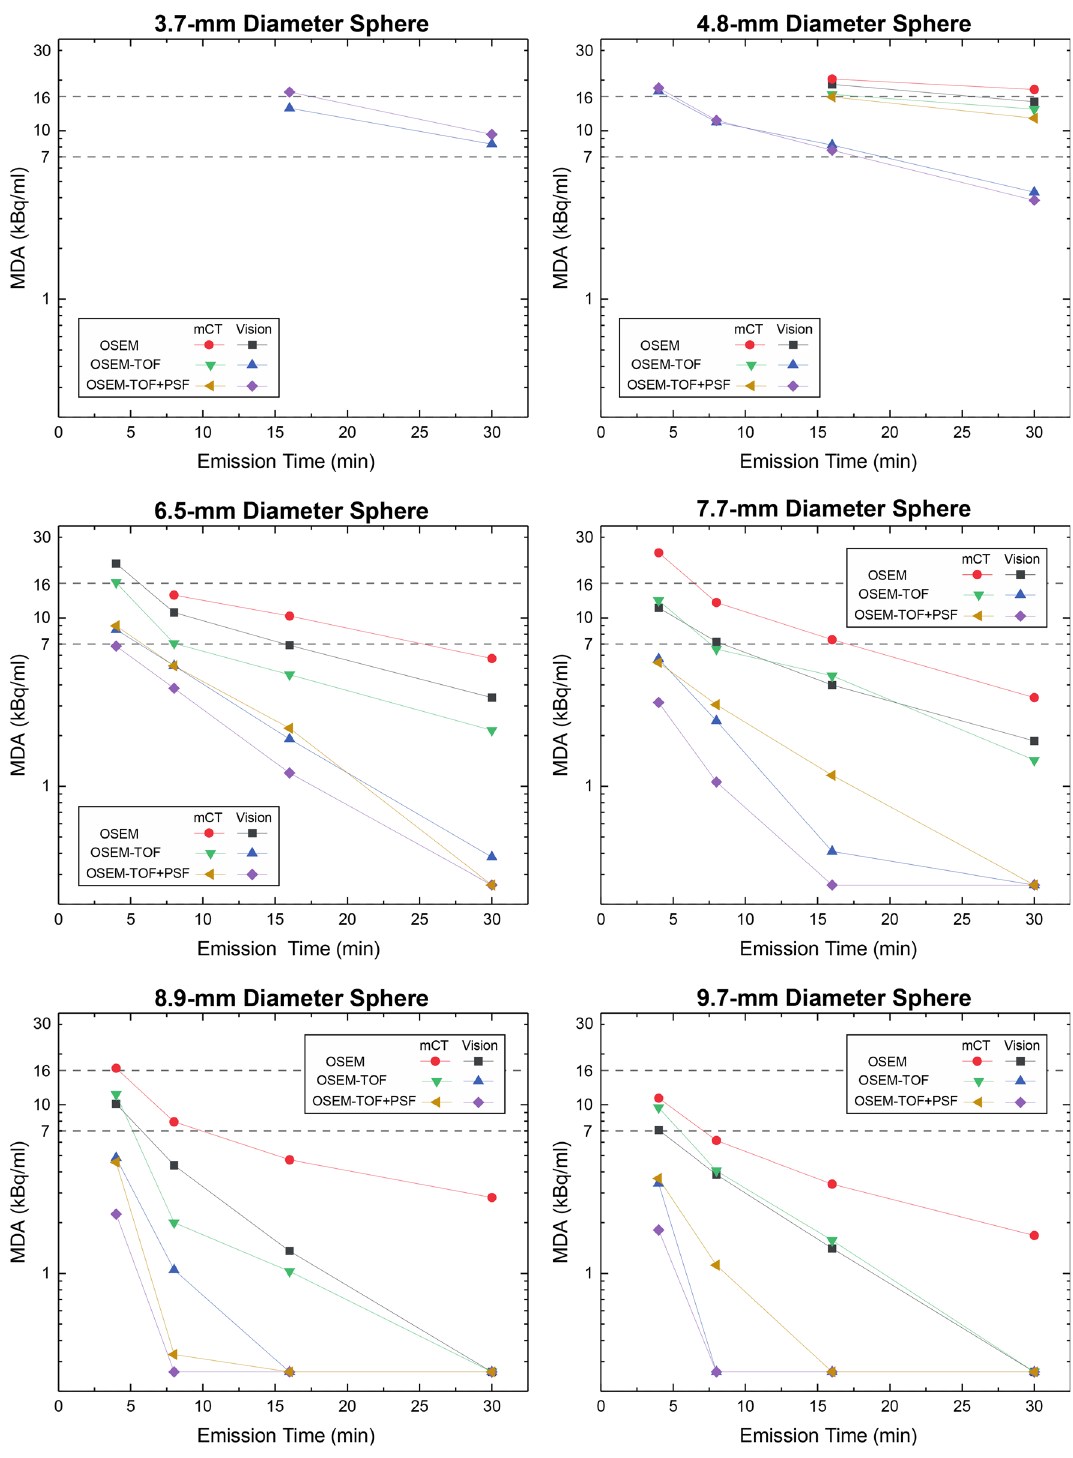
Figure 5. Semi-logarithmic representation of the MDA for both PET/CT systems as a function of the emission time for all spheres and image reconstructions. Horizontal lines at a MDA of 7 kBq/mL and at MDA of 16 kBq/mL are the dividing lines for the low, medium, and high absorbed dose lesion groups. Data points of a MDA < 0.26 kBq/ml were set to 0.26 kBq/ml meaning that the respective sphere was detected at every AC in this